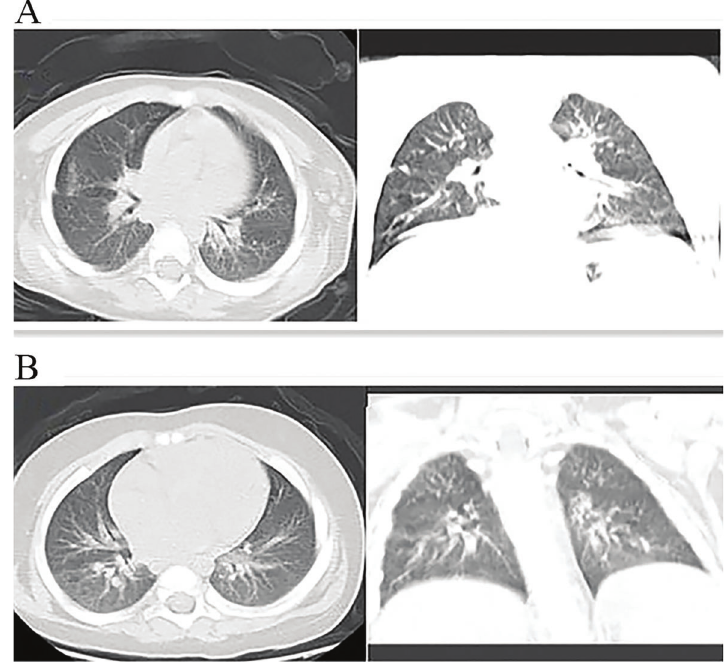
Figure 2. A, Double pneumonia with multiple patchy lesions before therapy. B , Decrease of pulmonary in fl ammation after